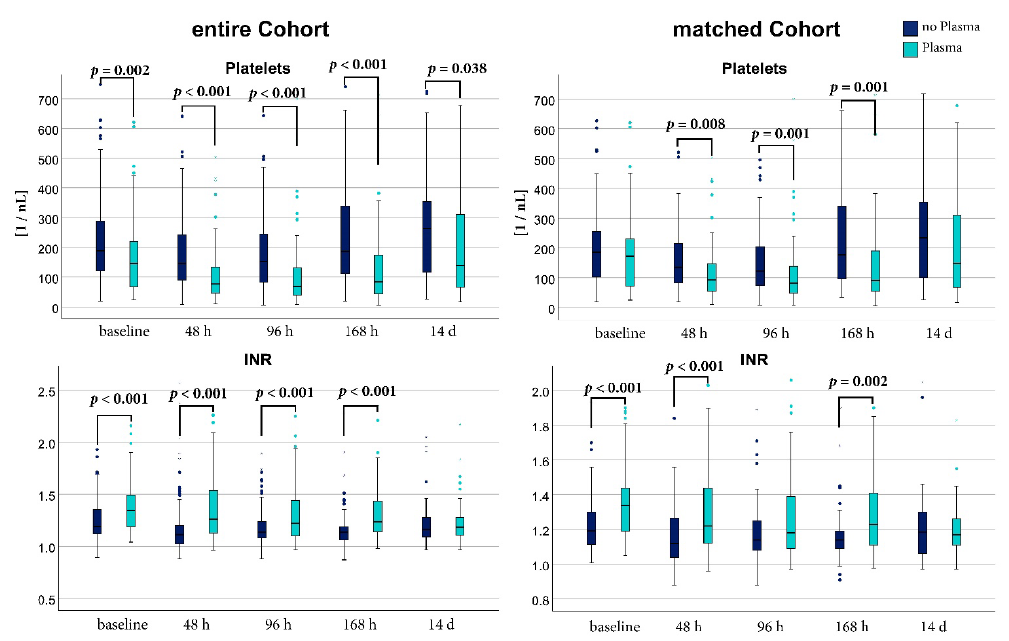
Figure 2. Global parameters of coagulopathy at different points in time of the unmatched and the matched cohort. Platelet count is reported in units per nanoliter [1/nL], international normalized ratio (INR) is reported without unit. A Mann-Whitney-U test was used or comparison between the plasma group (cyan) and the control group (dark blue). [h]: hours; [d]: days.